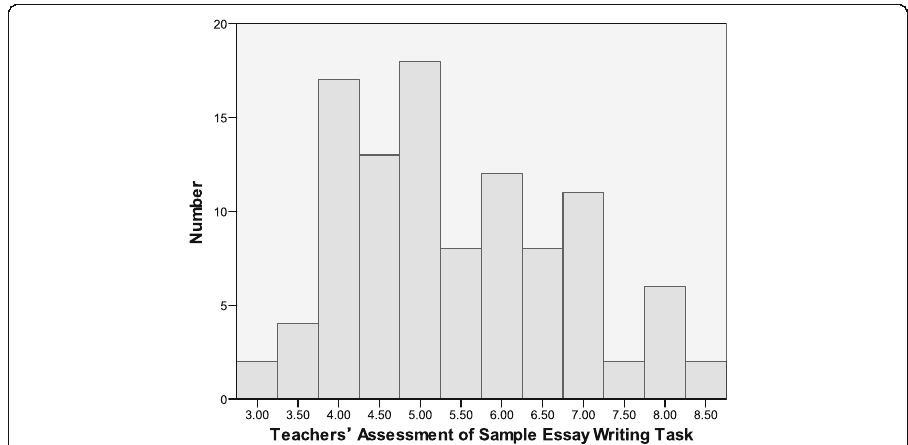
Fig. 5 Teachers ’ assessment of sample essay writing